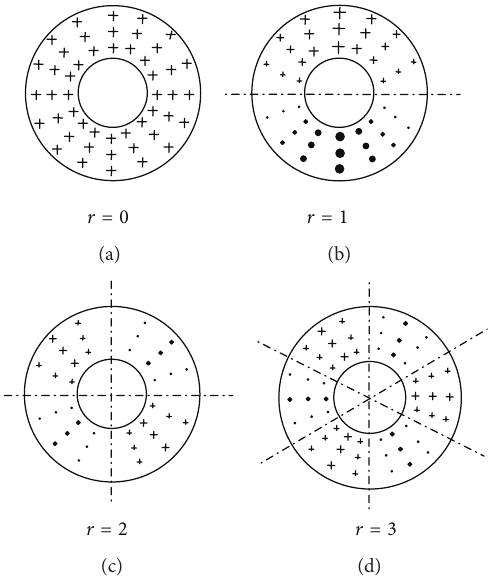
Figure 1: Normal electromagnetic forces distribution of axial flux permanent magnet synchronous motor.